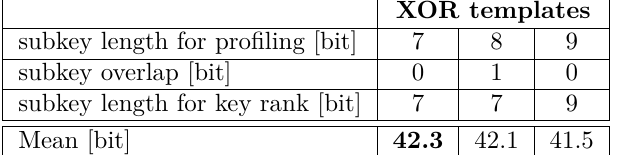
Table 2: Average security levels after attacking with different templates for 10k keys